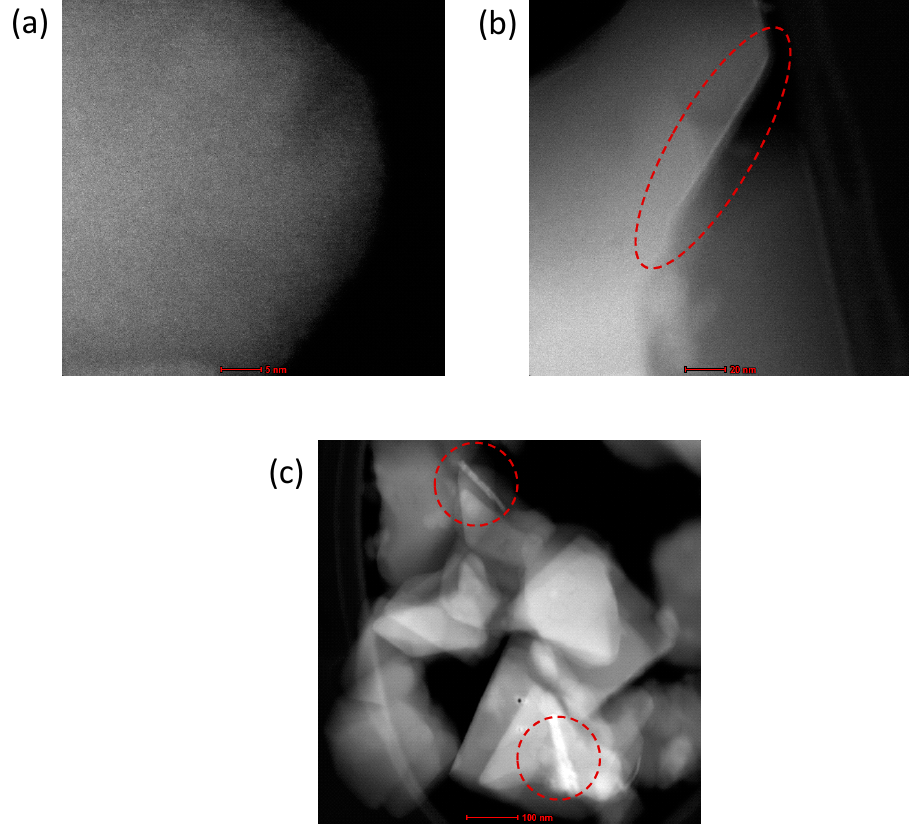
Figure 4. TEM images of fresh Fe/SSZ-13 catalyst (1.20 wt% Fe loading): ( a ) representative individual particles; ( b ) occasional individual particles with Fe enrichment at particle edges; ( c ) larger scale image with needle-shaped Fe-oxide particles. Scale bars for ( a ), ( b ) and ( c ) are 5, 10 and 100 nm, respectively. Reprinted with permission from [32]. Copyright © 2017 American Chemical Society.